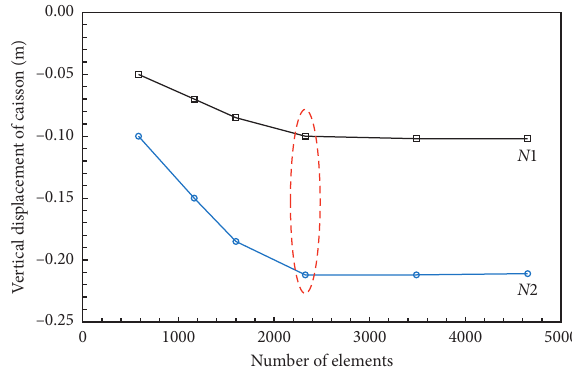
Figure 13: Mesh convergence